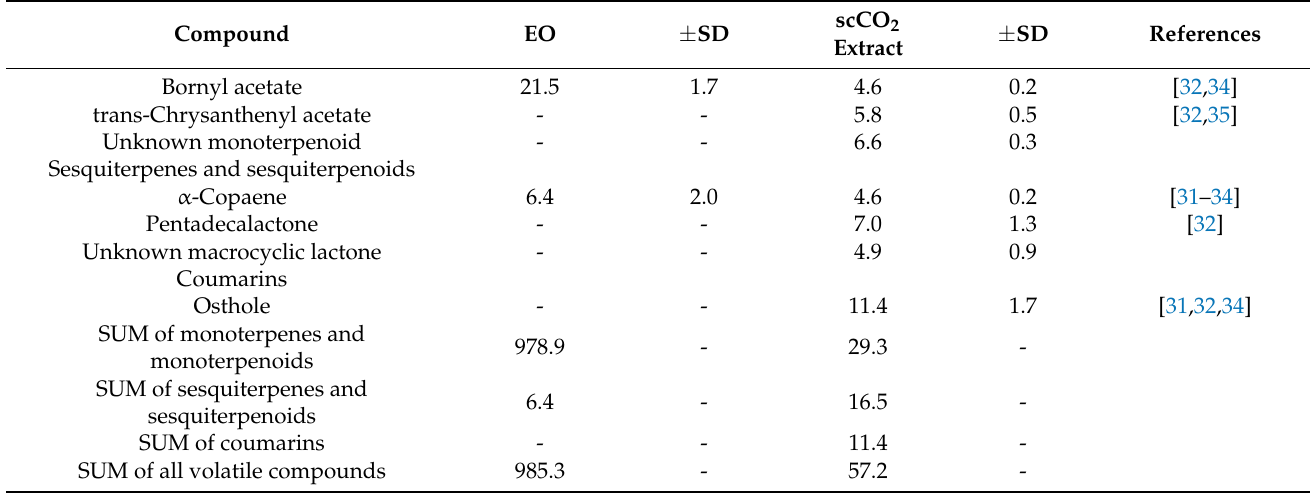
Table 4. Terpene content (mg/g) of air-dried marsh Labrador tea EO ( 2 ) and scCO 2 extract ( 5 ). Terpene Compound